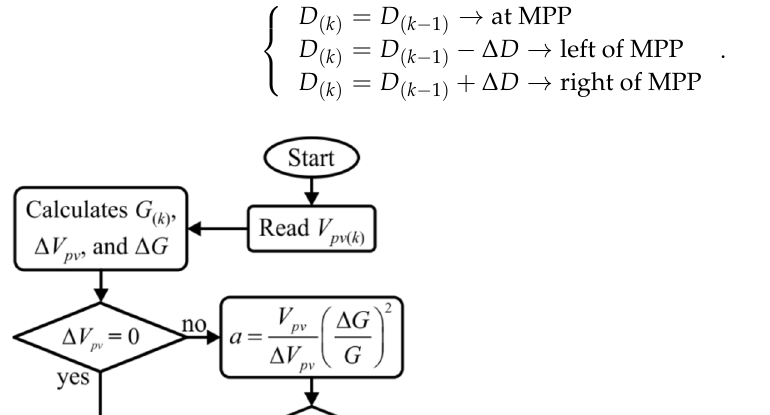
Figure 5. MPPT system for evaluating the proposed tracking algorithm.